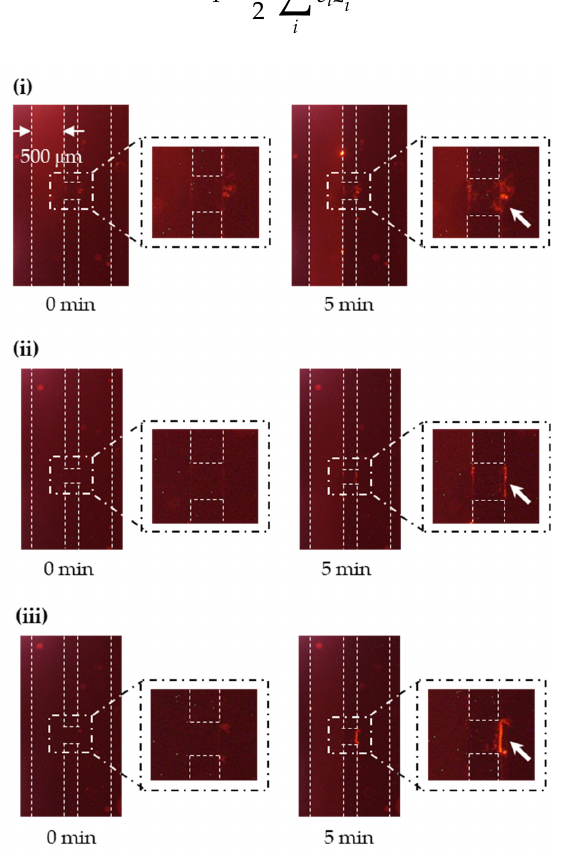
Figure 4. Fluorescence images during the size sorting of exosomes under each experimental condition. White dashed lines denote the microchannels and nanochannels, while white dot-dashed lines enclose the enlarged view around the nanochannels. White arrows indicate that the exosomes can pass through the nanochannels within 5 min. The concentration of the running buffer is ( i ) 1 × 10 − 3 , ( ii ) 1 × 10 − 4 , and ( iii ) 1 × 10 − 5 M 2-(4-(2-hydroxyethyl)-1-piperazinyl)ethane sulfonic acid (HEPES). Micromachines 2020 , 11 , 458